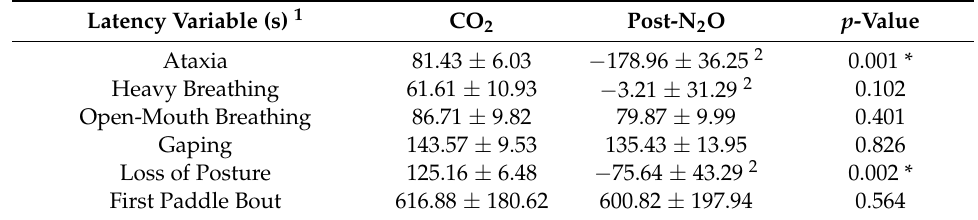
Table 7. Post-N 2 O vs. CO 2 treatment latency data (mean ± SE) on groups of piglets for Experiment 1.